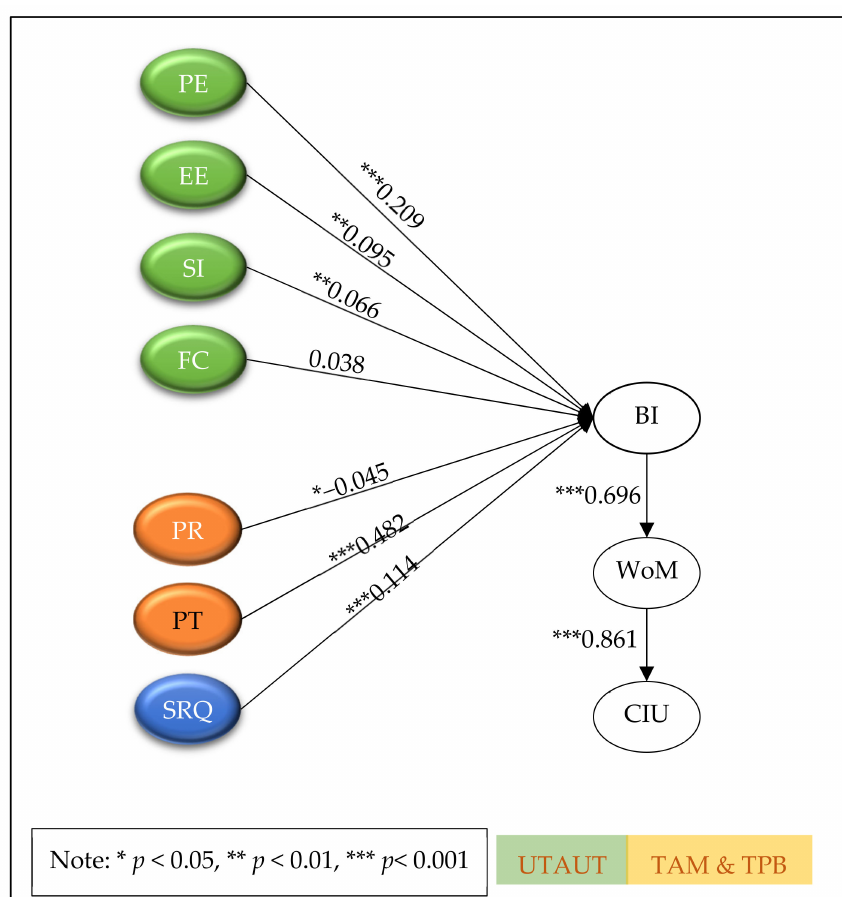
Figure 2. Proposed model with results of coefficient value.